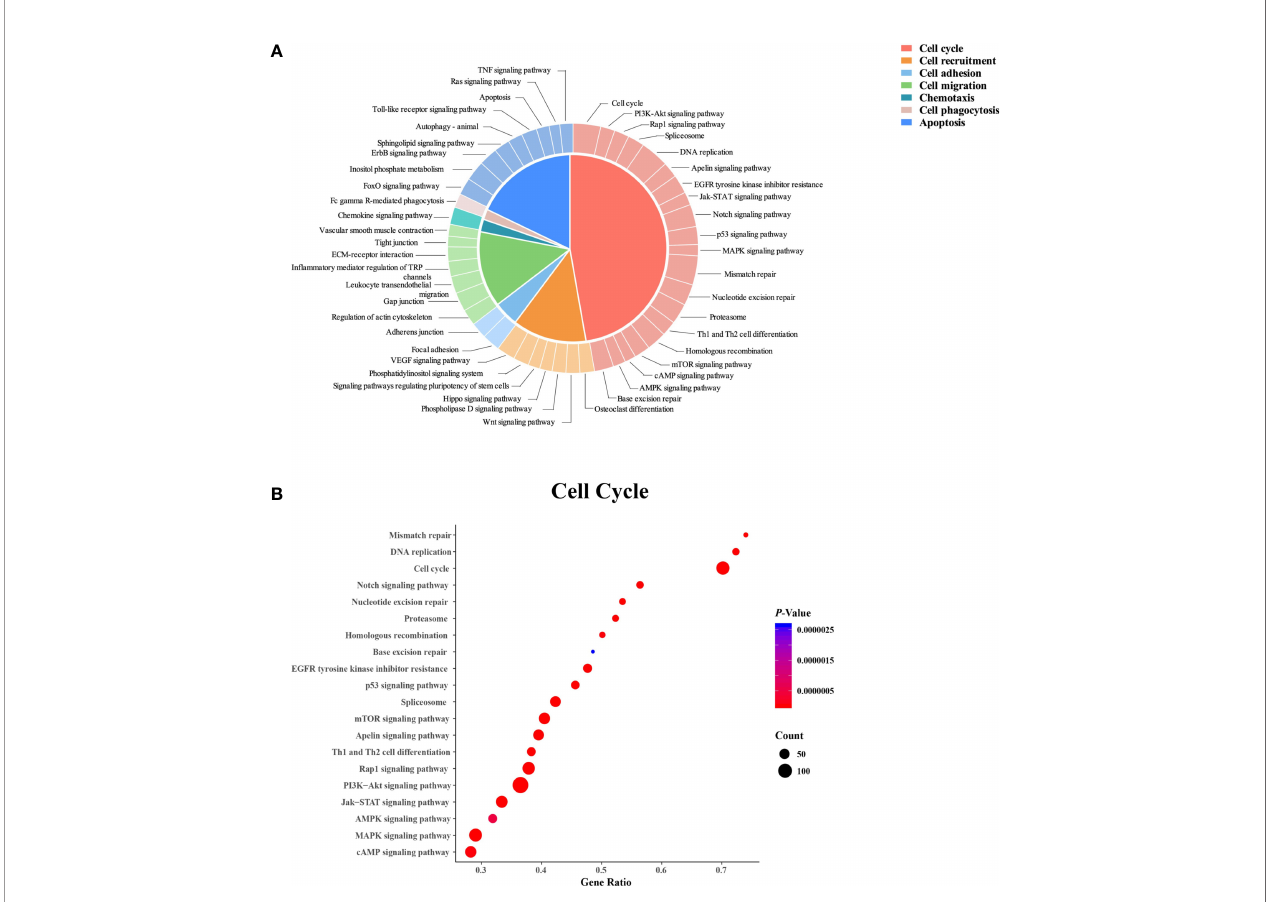
FIGURE 4 | Kyoto Encyclopedia of Genes and Genomes (KEGG) pathway analysis of the differentially expressed genes in neutrophils from dairy cows with high or low somatic cell counts at Week 1 prepartum. (A) The KEGG pathways. (B) Cell cycle-related pathways. In (B) the x-axis shows the gene ratio, and the y-axis displays the enrichment related to the cell cycle pathway. The circle size represents the number of genes, and the color indicates the P